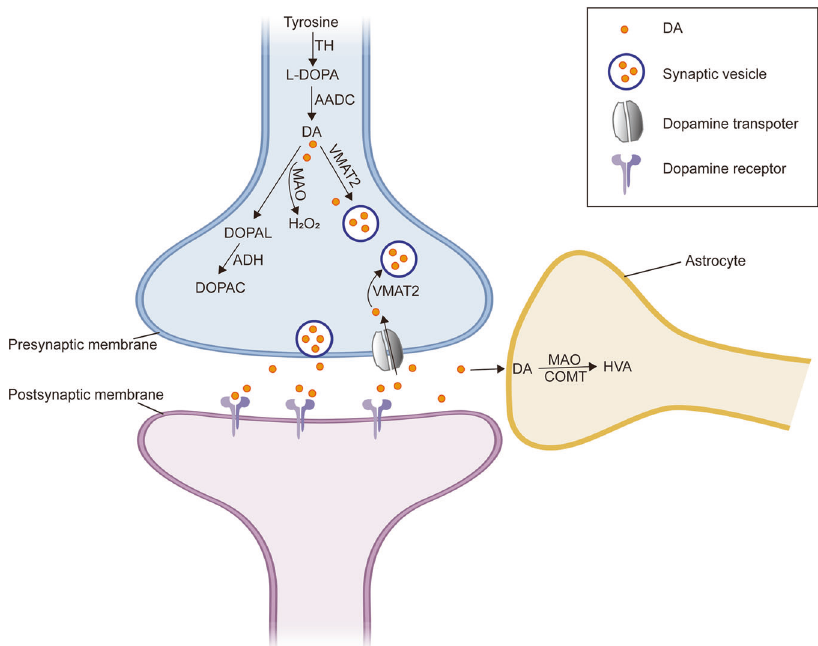
Fig. 1 DA metabolism in dopaminergic neurons. In addition to the uptake of DA by the DA transporter (DAT) from outside, Dopaminergic neurons produce DA under the action of tyrosine hydroxylase (TH) and aromatic amino acid decarboxylase (AADC). The newly synthesized or taken up DA is stored in vesicles with the aid of vesicular monoaminergic transporter-2 (VAMT2). Cytosolic DA can be degraded in neurons or glial cells by catechol-o-methyltransferase (COMT) or monoamine oxidase (MAO) to form homovanillic acid (HVA) or be oxidized to form the metabolites (DOPAL, and DOPAC) and hydrogen peroxide (H 2 O 2 ). The fi g was modi fi ed from that by Zhang et al. (2019) 153